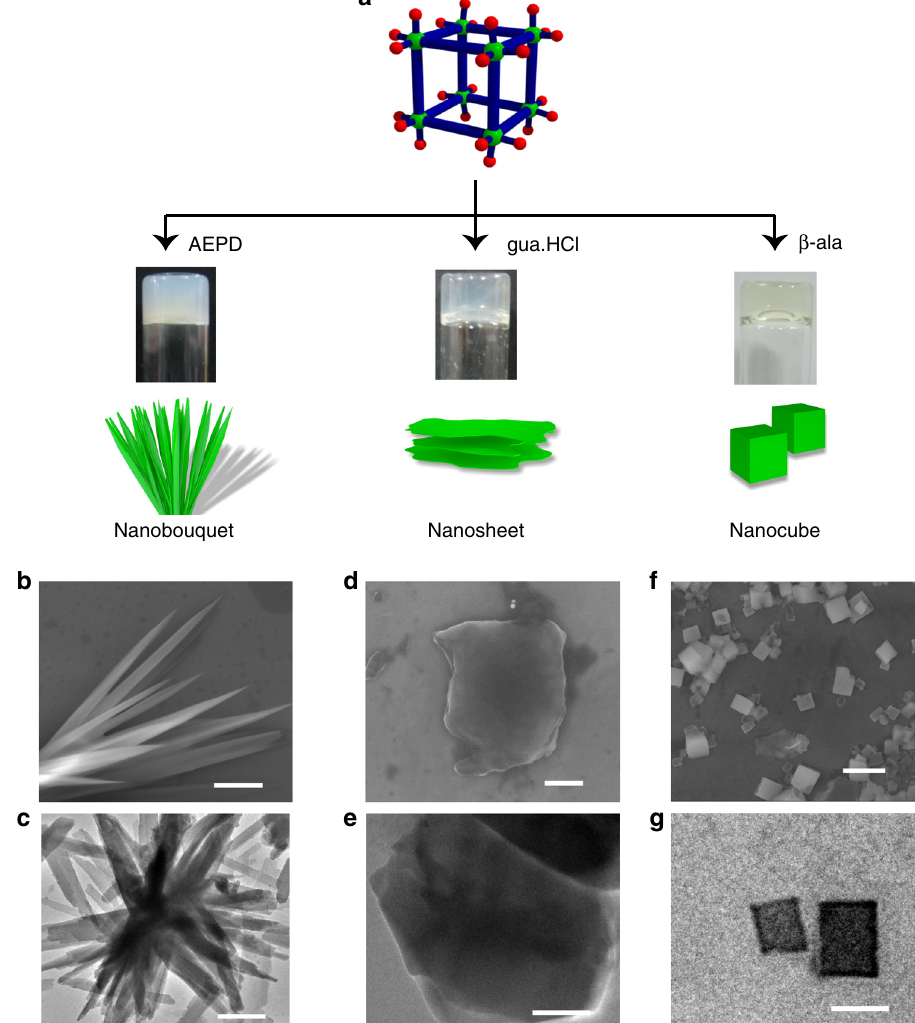
Fig. 4 Different morphologies of MOC -based hydrogels. a Self-assembly of MOC with molecular binders, N-(2-aminoethyl)-1,3-propanediamine (AEPD), guanidine hydrochloride (gua.HCl) and β -alanine ( β -ala) results in stable hydrogels with nano-bouquet, nano-sheet and nano-cube morphologies, respectively. b FESEM and c TEM images (scale bar = 2 μ m) of MOC - G2 hydrogel showing the formation of nano-bouquet morphology. d FESEM (scale bar = 500 nm) and e TEM (scale bar = 200 nm) images of MOC - G3 hydrogel showing the formation of nano-sheet morphology. f FESEM (scale bar = 1 μ m) and g TEM (scale bar = 200 nm) images of MOC - G4 hydrogel showing the formation of nanocube Table 3). To further determine binding af fi nities of the molecular binders, isothermal titration calorimetric (ITC) experiments are performed at 25 °C. With incremental addition of NH 4 + , AEPD, β -ala and gua.HCl aliquots to the aqueous solution of MOC , exothermic heat changes are observed (Supplementary Figures 32 and 33). The binding af fi nity values ( K a ) for the NH 4 + , AEPD, β -ala and gua.HCl binders are found to be 6.65 × 10 4 , 6.76 × 10 4 , 6.50 × 10 4 and 2.73 × 10 4 M − 1 , respectively, indicating binding tary Table 3). The results are in good agreement with the morphological distributions obtained from MOC-GM1 , MOC- GM2 , MOC-GM3 and MOC-GM4 .